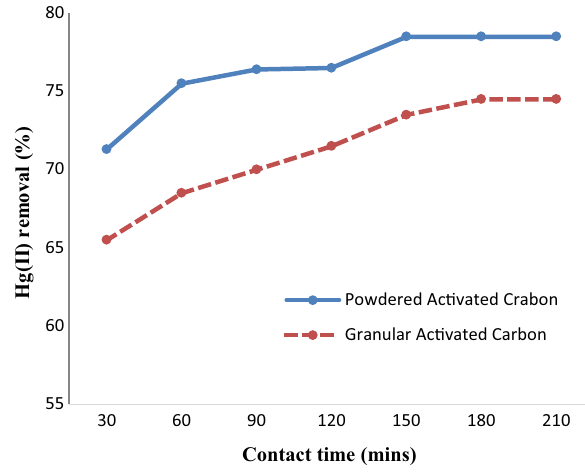
Fig. 6 Hg removal (%) versus Contact Time (mins) for powdered activated carbon (PAC) and granular activated carbon (GAC) (20 g adsorbent, pH = 6.05, 40.41 mg/L Hg(II) ions